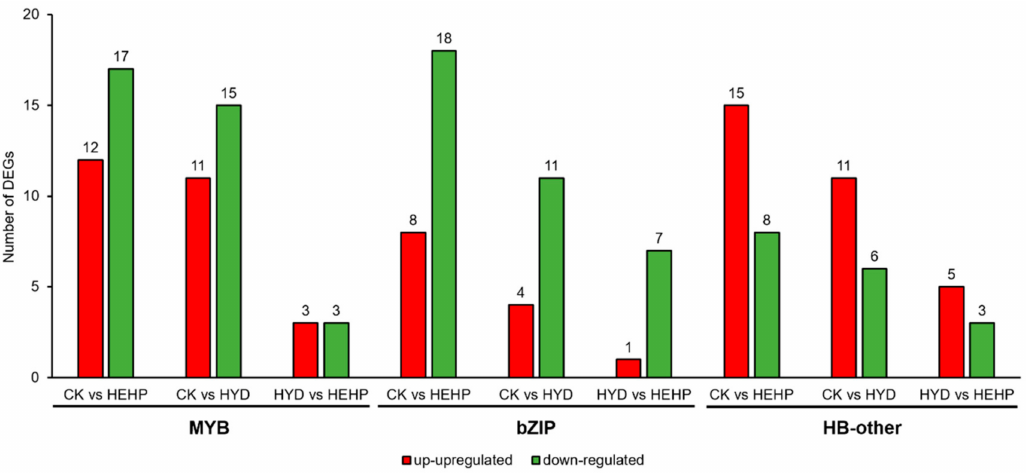
Figure 10. Statistics of DEGs among CK, HYD and HEHP encoding MYB, bZIP and HB-other family